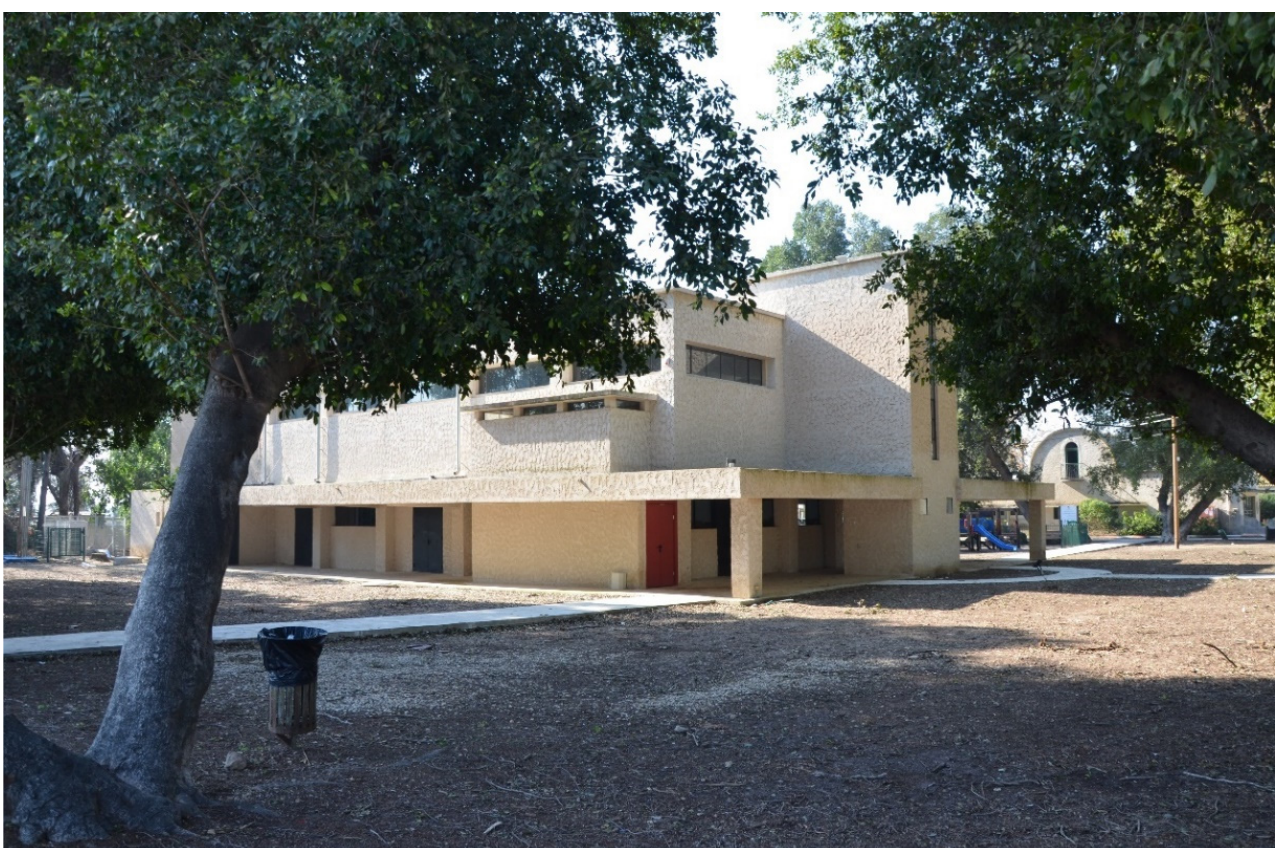
Figure 9. The renovated historic community center in Nahalal, planned by Richard Kaufmann. Photo by the authors.